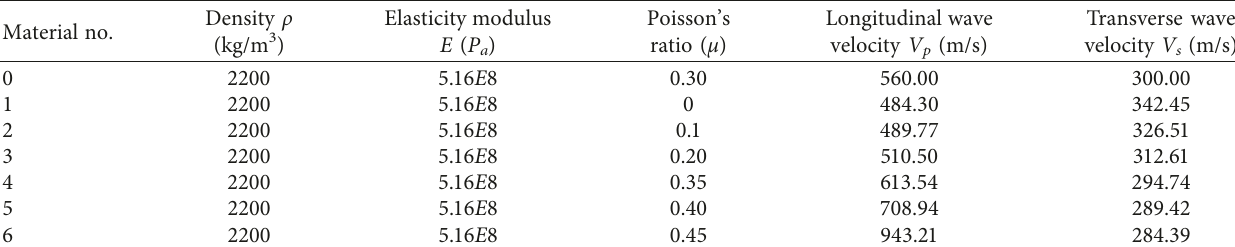
Table 2: Material parameters for defects corresponding to different Poisson’s ratios. Material